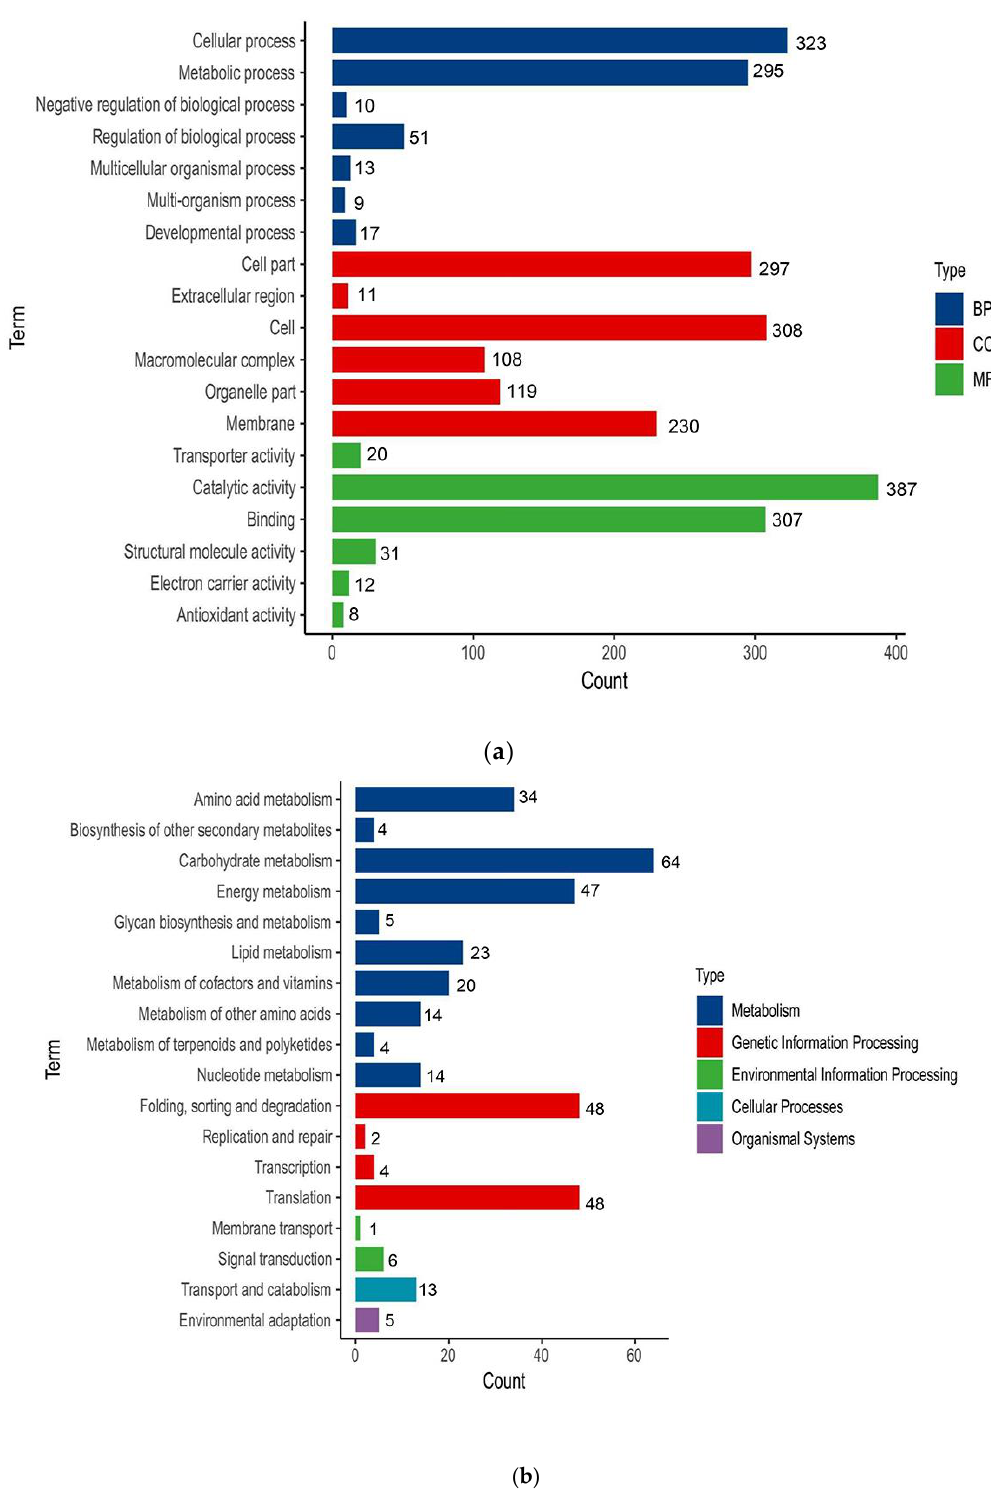
Figure 2. Annotation analysis of the DAPs: ( a ) Protein GO analysis of First/Fifth harvest (MF: Molecular function; CC: Cellular component; BP: Biological process). ( b ) Protein KEGG analysis of First/Fifth harvest.